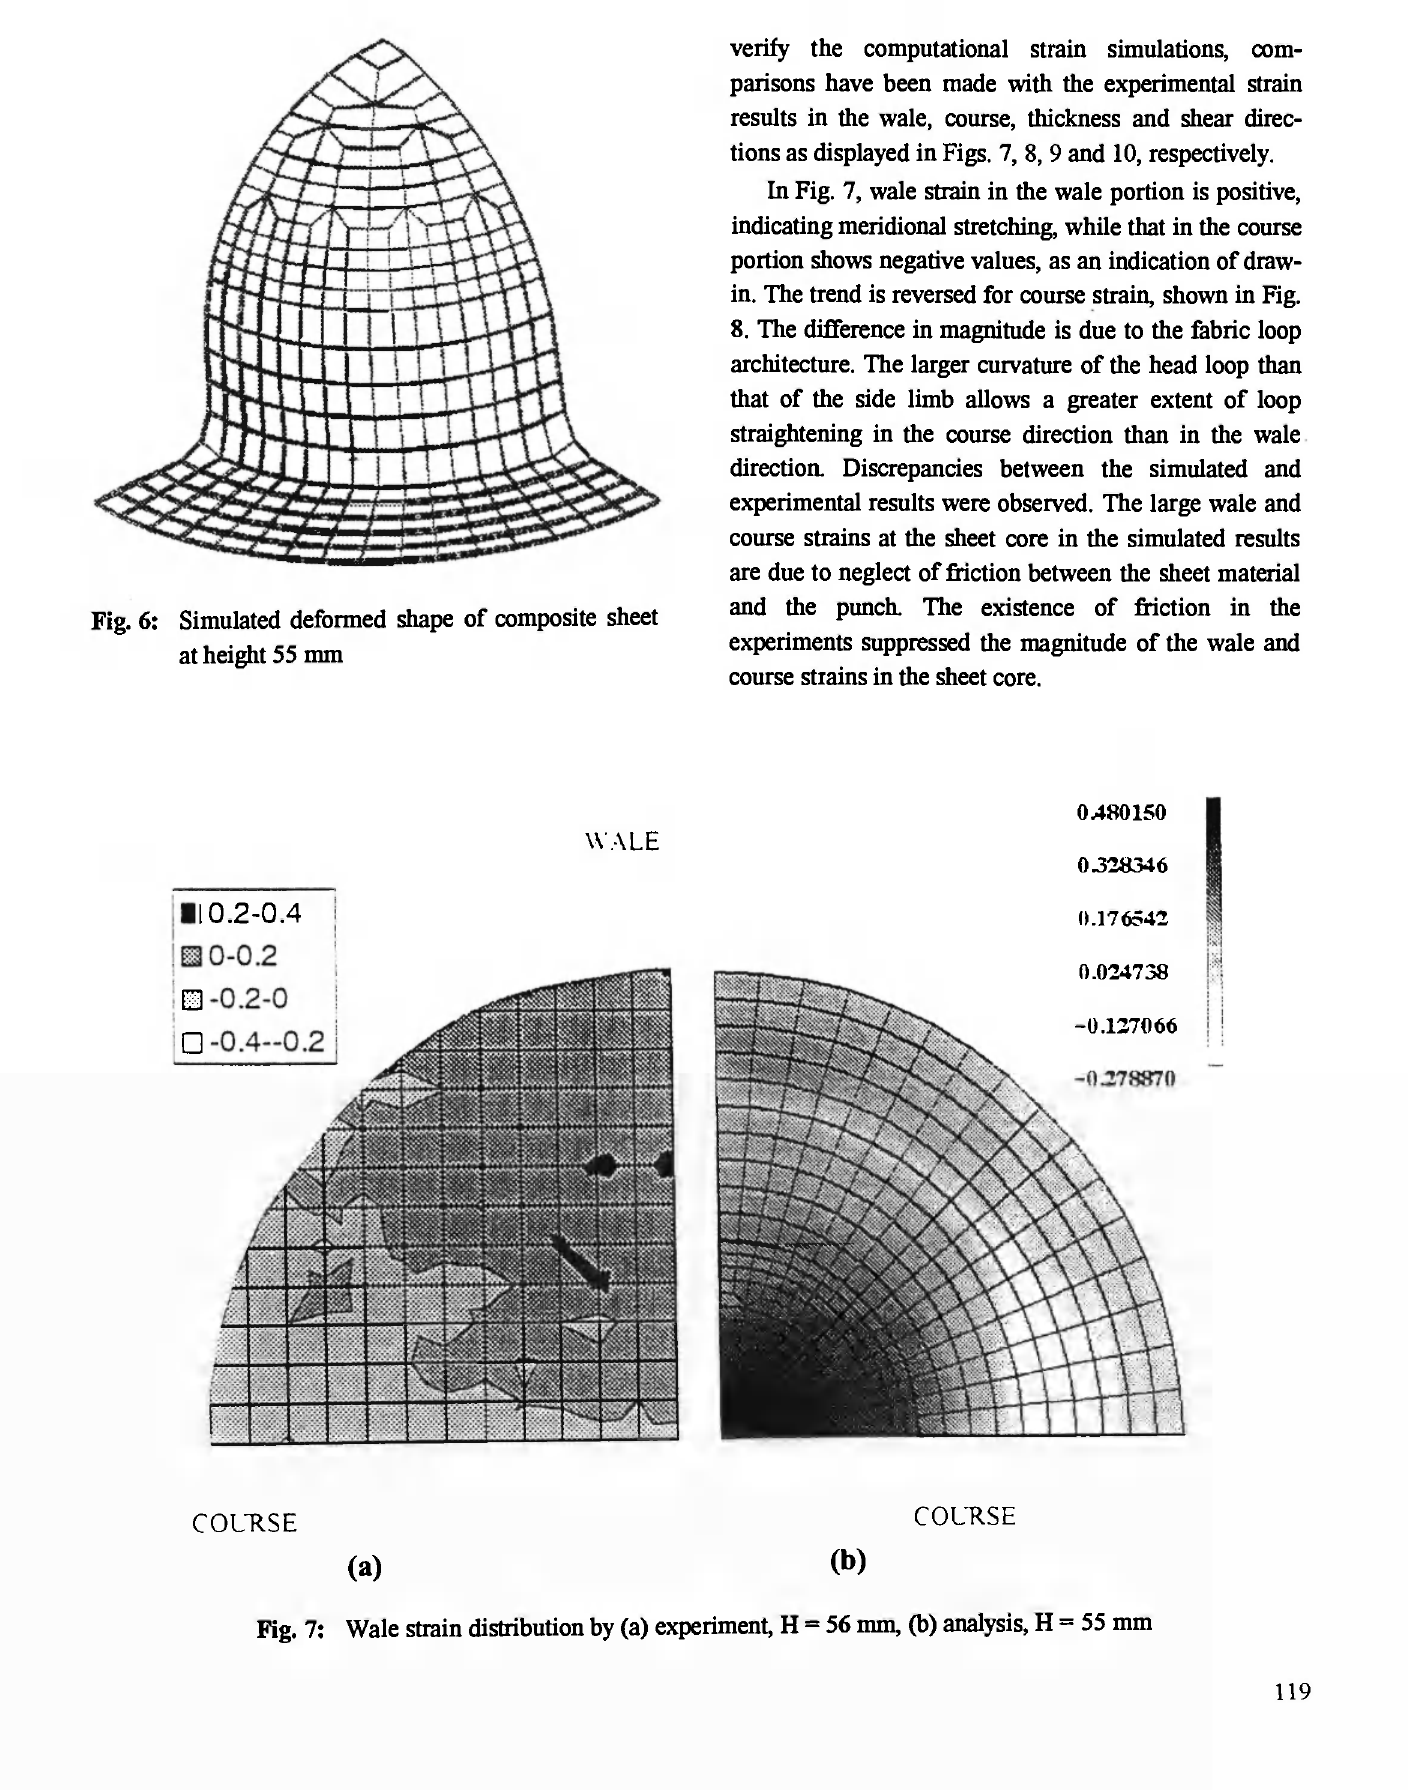
Fig. 7: Wale strain distribution by (a) experiment, Η = 56 mm, (b) analysis, Η = 55 mm